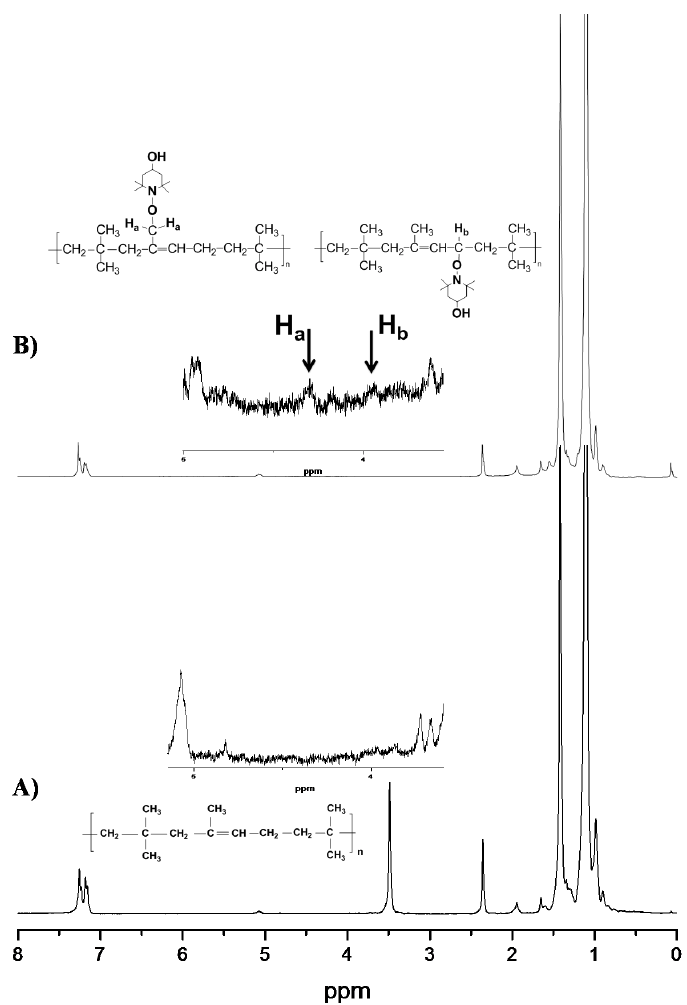
Figure 2. 1 H NMR spectra of ( A ) IIR and ( B ) IIRF1.